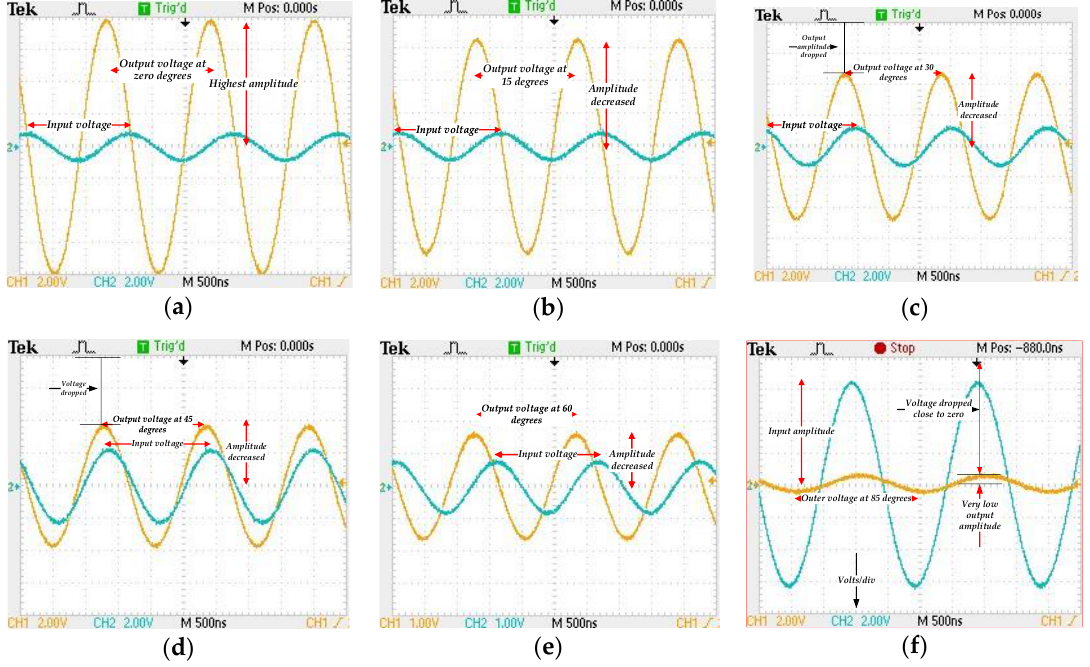
Figure 22. Input (blue) and output (orange) coil-to-coil voltages for the hemisphere windings: ( a ) α = 0°; ( b ) α = 15° ; ( c ) α = 30° ; ( d ) α = 45° ; ( e ) α = 60° ; ( f ) α = 85°.